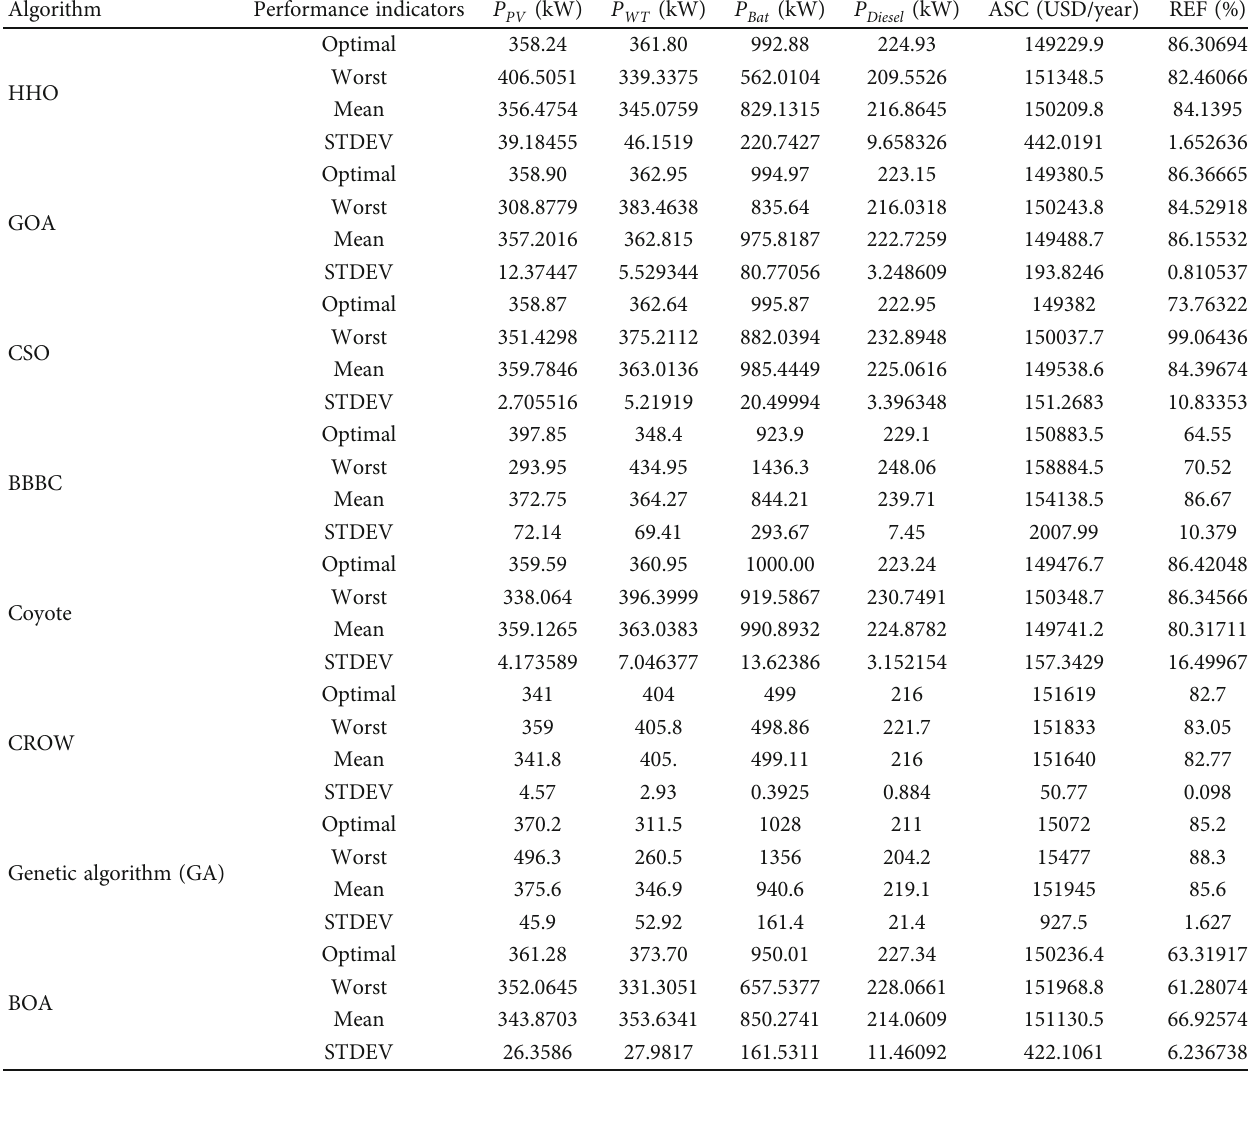
Table 1: Results of the HHO compared with seven metaheuristic optimization algorithms. Algorithm